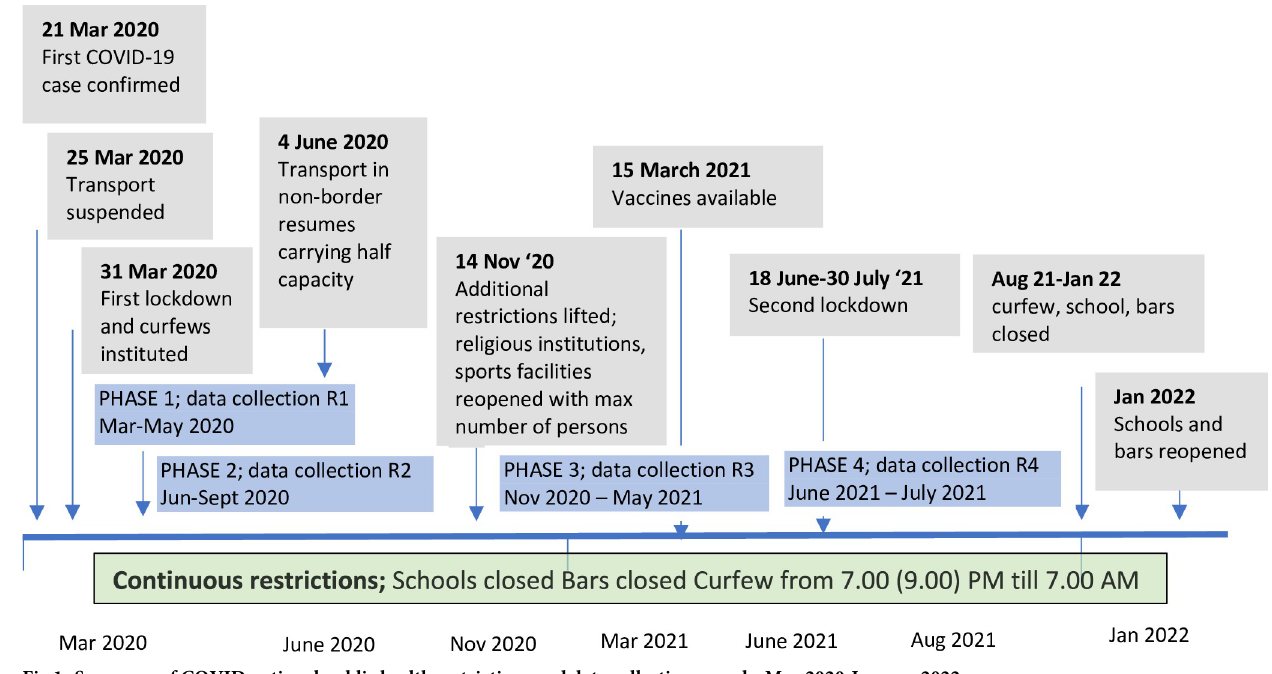
Fig 1. Summary of COVID national public health restrictions and data collection rounds; May 2020-January 2022.